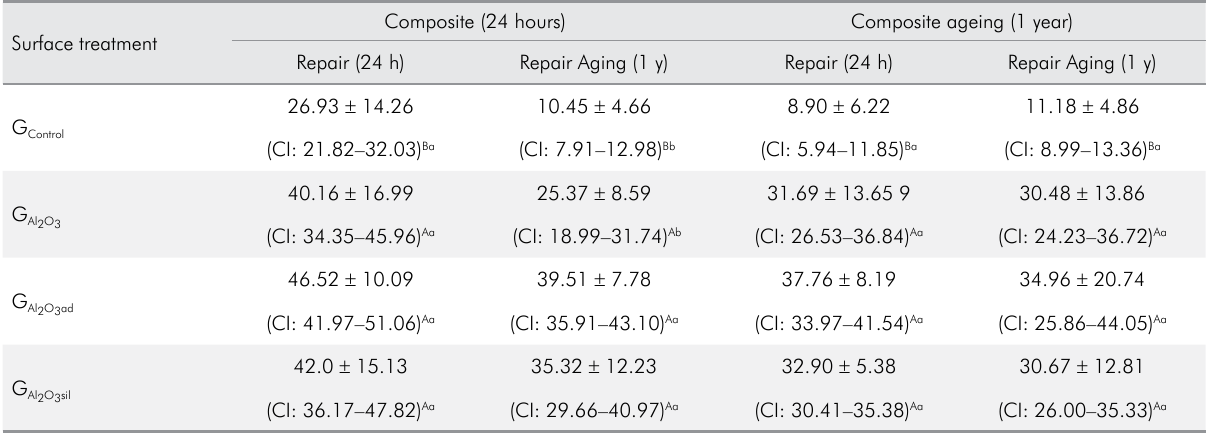
Table 2. Date of microtensile bond strength of composite and repair according to storage time and surface treatment. Surface